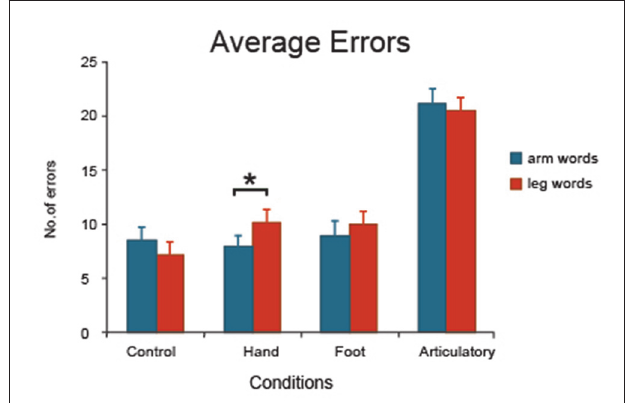
FIGURE 1 | Average errors made on arm- and leg-related words and standard error measures in each experimental condition (control, hand movement, foot movement and articulatory). Finger tapping led to enhanced memory performance for arm-related words in comparison to leg-related words. ∗ Indicates